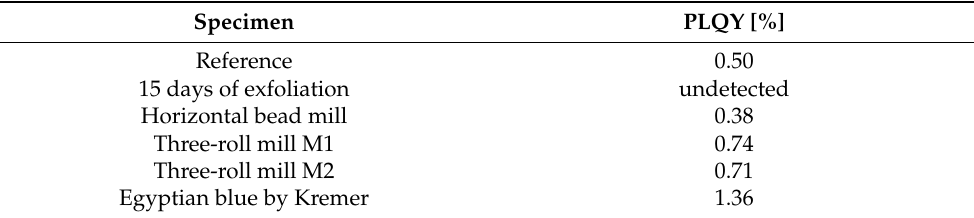
Table 2. Photoluminescence quantum yield with respect to dispersion method.